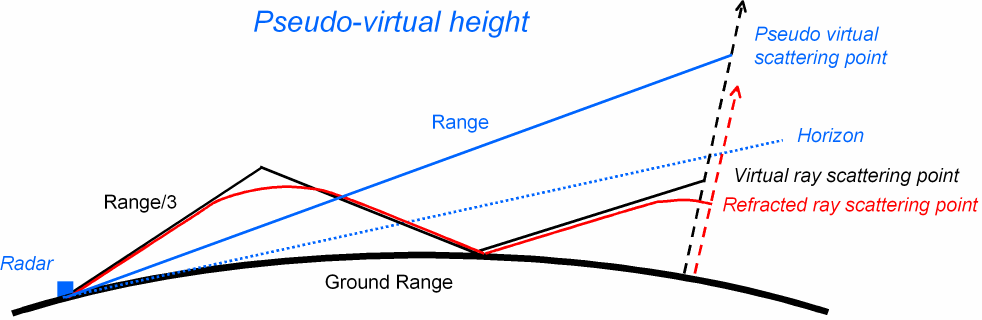
-hop backscatter. The curved bold black line 2